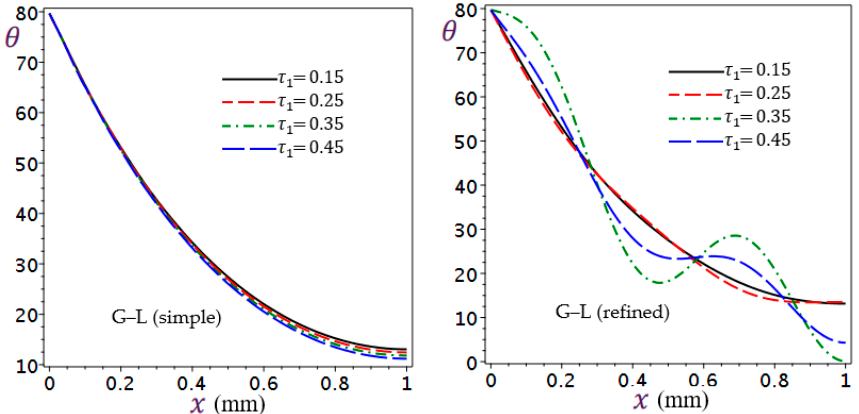
Figure 10. Effect of first relaxation time 𝜏 (cid:2869) of G–L theory on temperature 𝜃 .